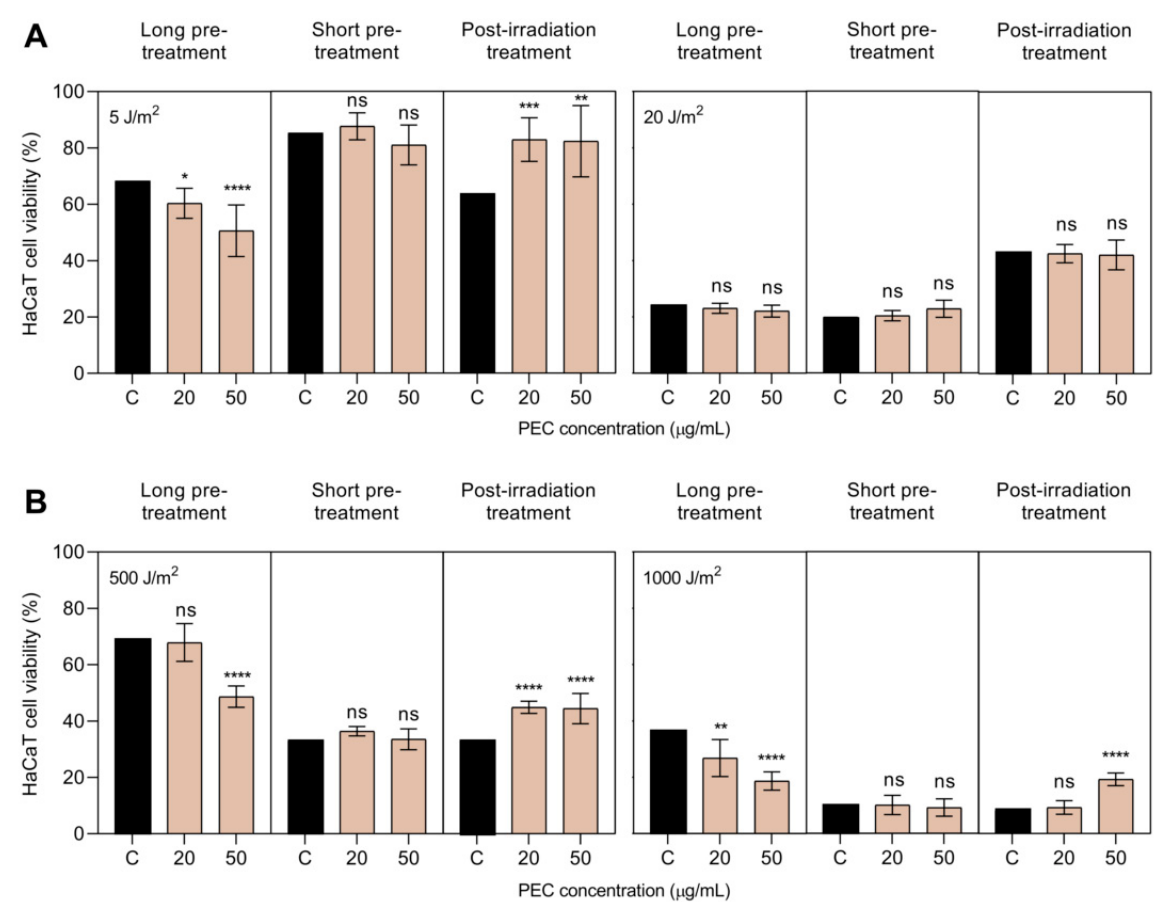
Figure 2. Viability of human keratinocytes (HaCaT) cells after long, short, and post-treatment with persimmon extract rich in carotenoids (PEC) at low (lPEC) and high (hPEC) concentration against ( A ) UV-A (5 and 20 J/m 2 ) and ( B ) UV-B (500 and 1000 J/m 2 ) irradiation intensities. PEC treatment at lPEC (20 µg/mL) and hPEC (50 µg/mL) led to a significant increase of HaCaT viability post-irradiation, compared to irradiated but non-treated control (C) (**** p < 0.0001, *** p < 0.001, ** p < 0.01, * p < 0.05, ns p > 0.05, ANOVA, and Dunnett’s post hoc test). All data were normalized, according to a non-irradiated control (100% viability).